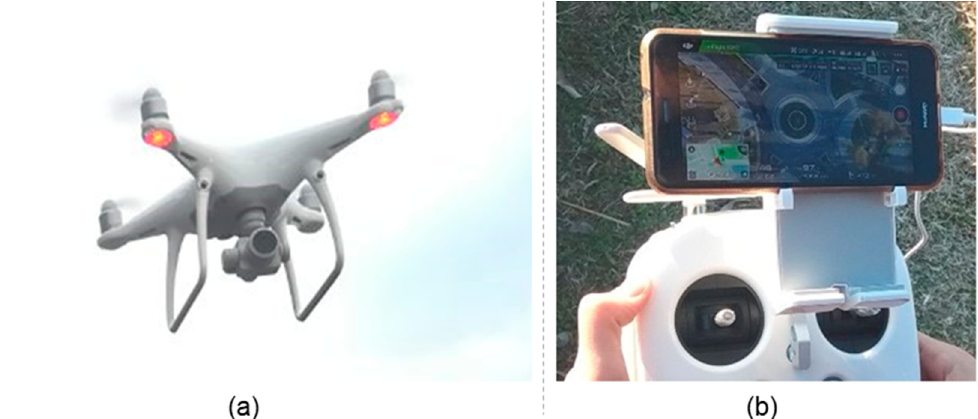
Figure 6. ( a ) The quadcopter UAV and ( b ) the captured study area as presented on the controller during the survey.